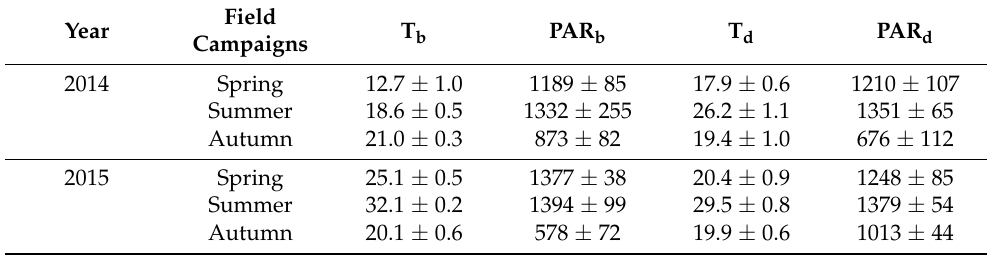
Table 4. Temperature ( ◦ C) and photosynthetically active radiation (PAR, µ mol m − 2 s − 1 ) one week before (T b and PAR b ) and during the field campaigns (T d and PAR d ). Values shown correspond to daily mean ± S.E. (n = 5), averaged between 12:00 and 15:00 (local time). Field T b PAR b T d PAR d Year Campaigns Spring 12.7 ±